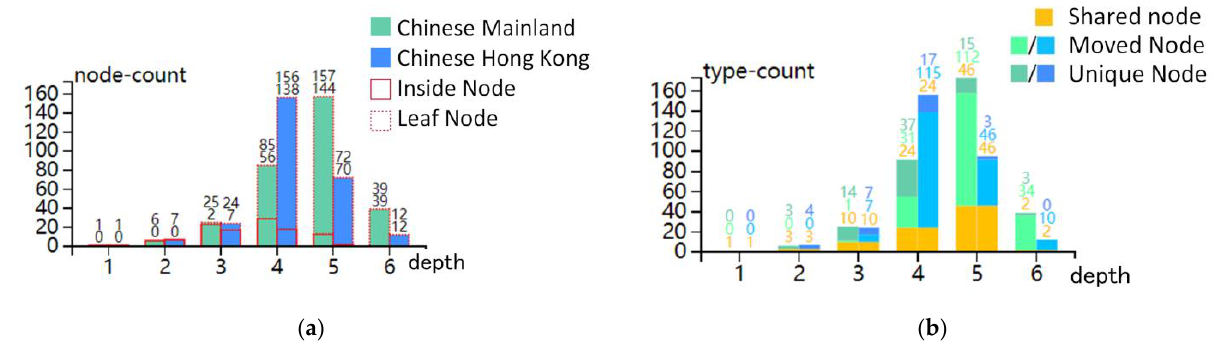
Figure 2. Data features of two FCTs. ( a ) Node distribution situation of two FCTs. The upper number indicates the number of all of the nodes in the current hierarchy, and the one below is the number of leaf nodes. ( b ) Node label matching situation of two